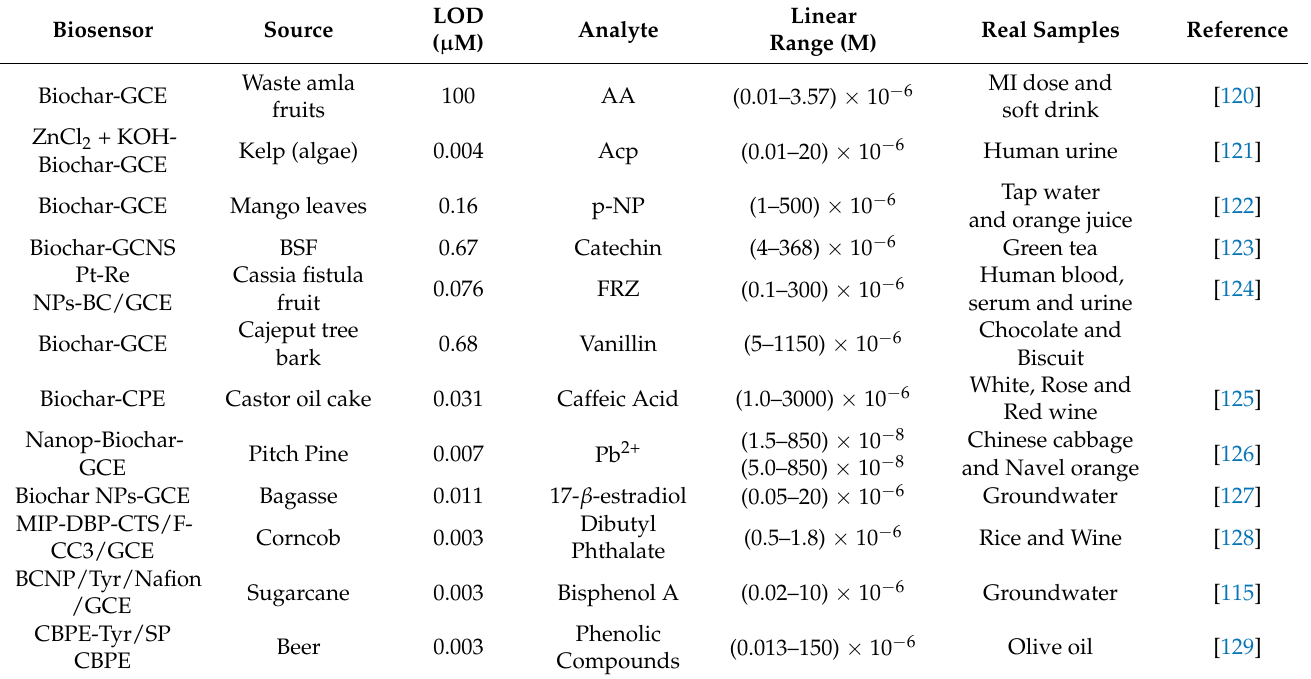
Table 5. Main source, preparation, application, limit of detection (LOD) and biosensors based on